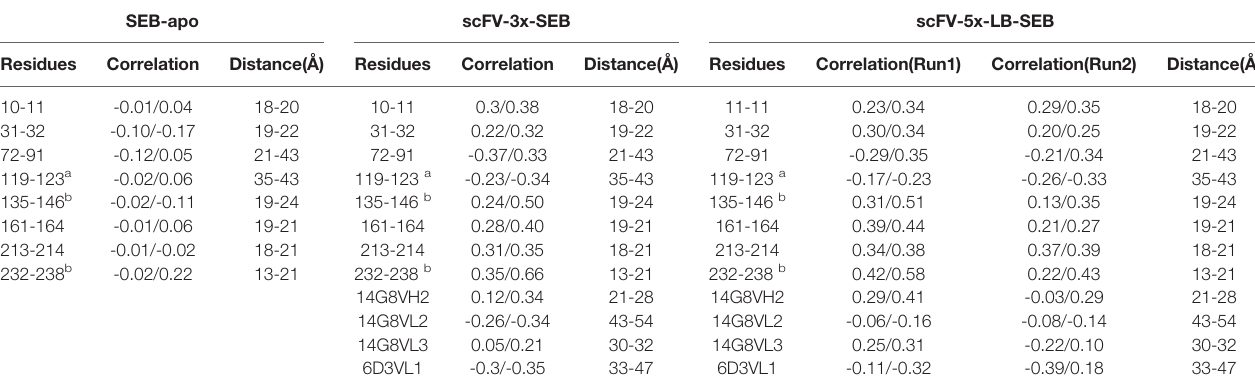
TABLE 3 | Allosteric correlations of Phe177 with SEB and scFV amino acid residues. SEB-apo scFV-3x-SEB scFV-5x-LB-SEB Residues Correlation Distance(Å) Residues Correlation Distance(Å) Residues Correlation(Run1)